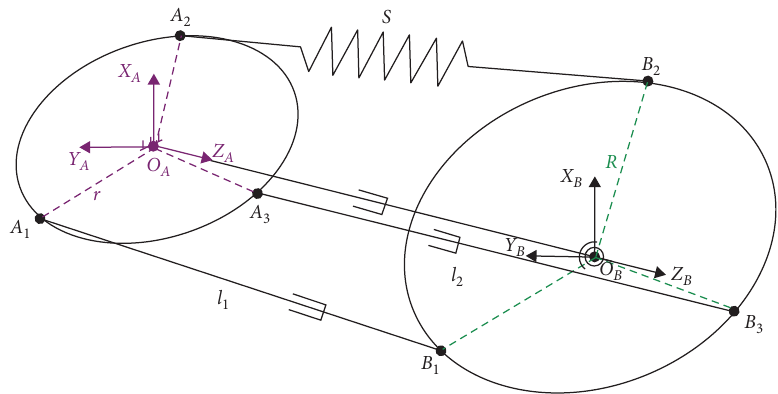
F IGURE 7: The schematic of the parallel